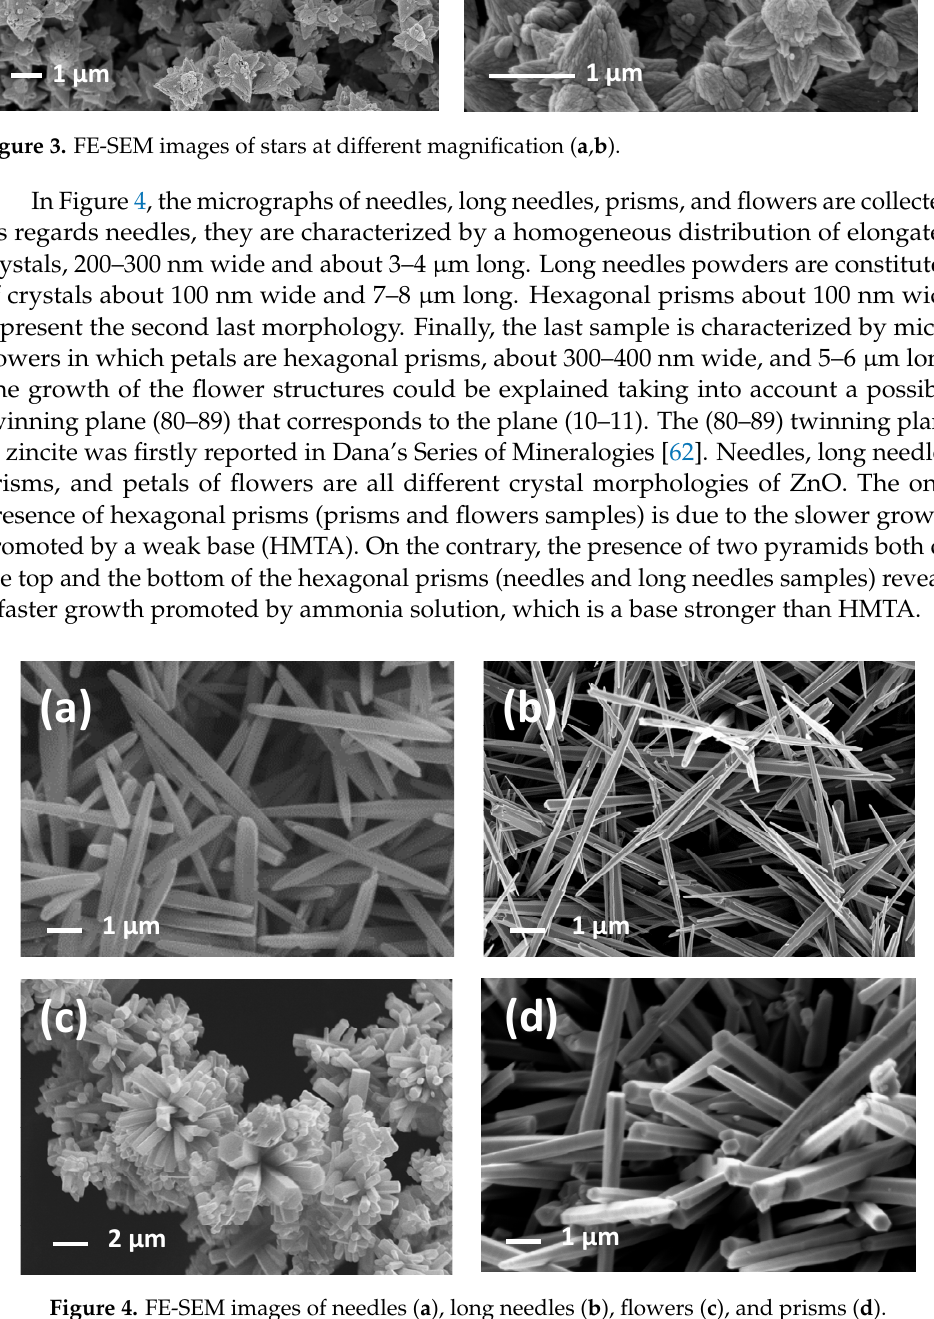
Figure 4. FE-SEM images of needles ( a ), long needles ( b ), flowers ( c ), and prisms ( d